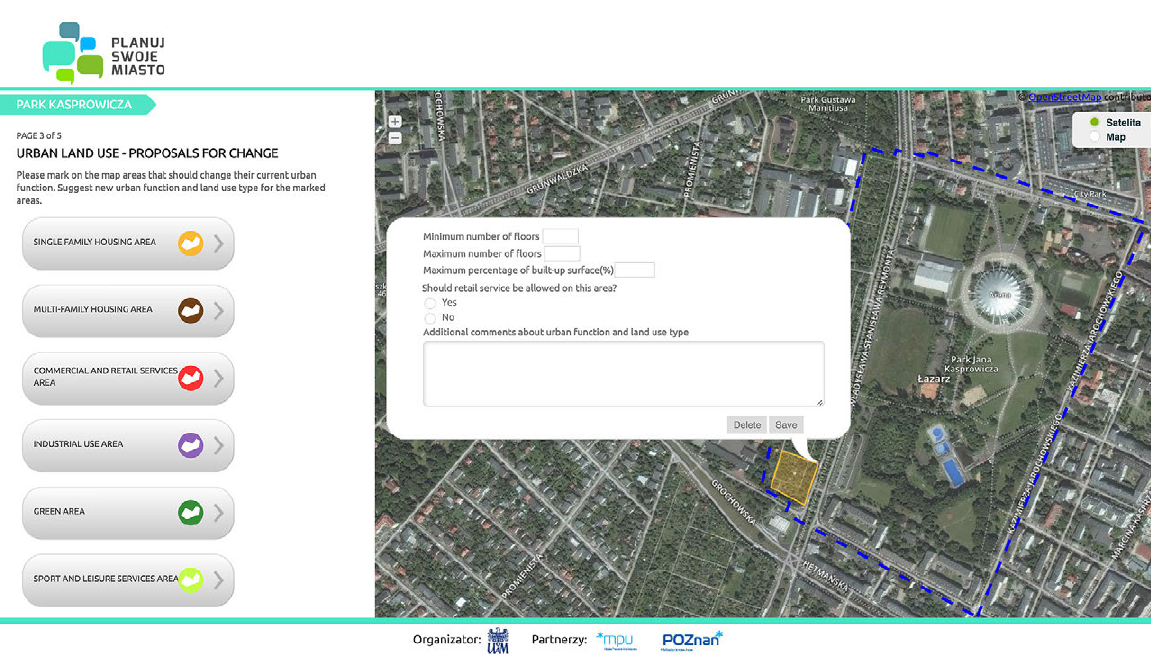
Fig. 1. Example page of a geo-questionnaire used in Kasprowicz Park case study in Poznan, Poland, described in section 6. The mapping tools on the page allow respondents to sketch polygons representing their development preferences and answer questions about preference details. The geo-questionnaire interface allows the respondents to toggle between a satellite image and a street map, pan and